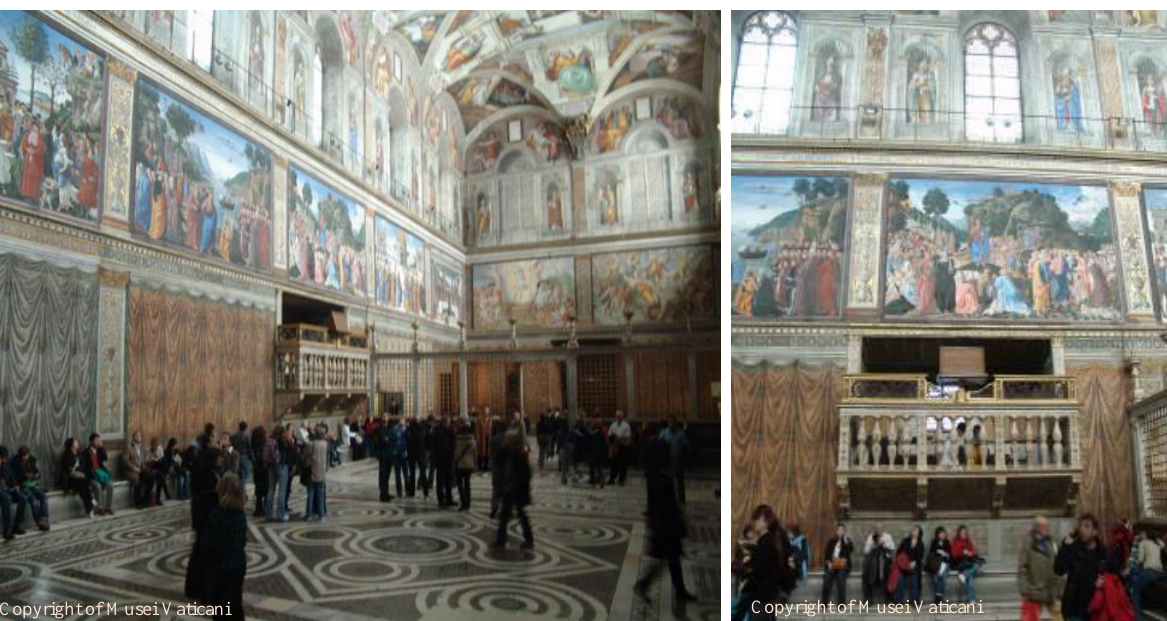
Figure 6. The ―Cantoria‖ viewed from the Sistine Chapel.